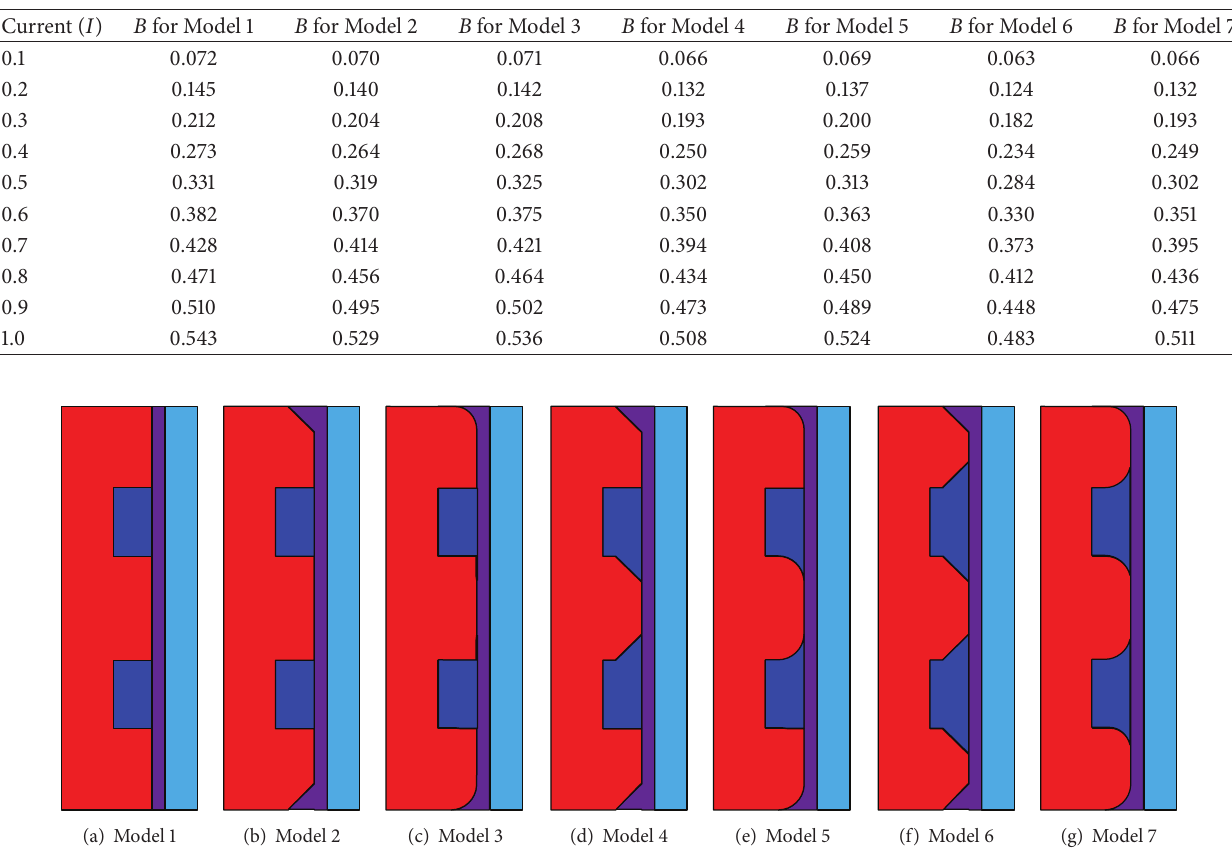
Table 2: Magnetic flux density comparison among different models.